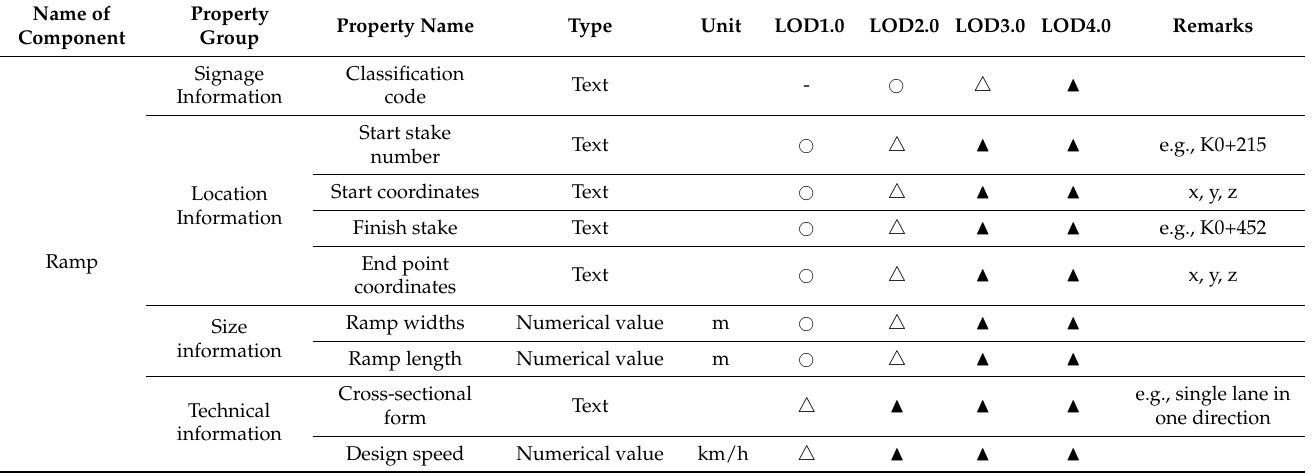
Table 9. Level of interchange BIM components’ unique